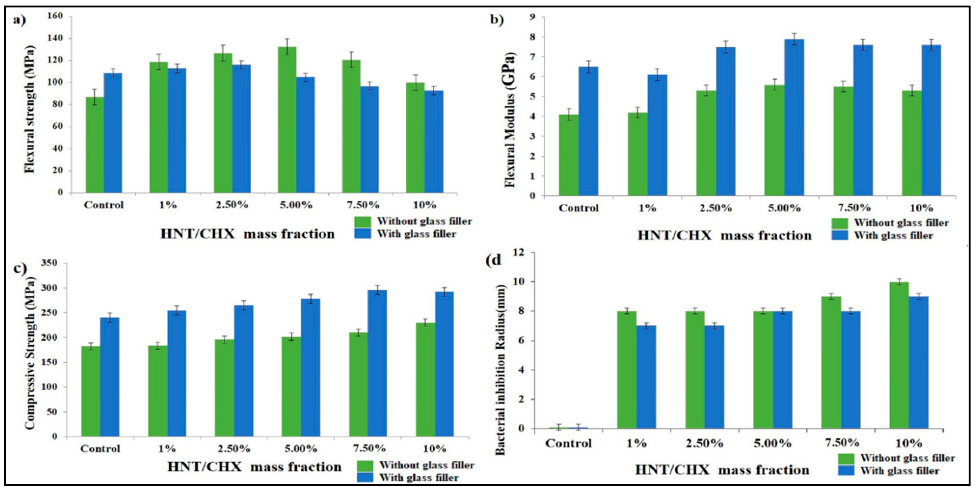
Figure 4. Mechanical properties of dental resin composites with varied amounts of HNT/CHX